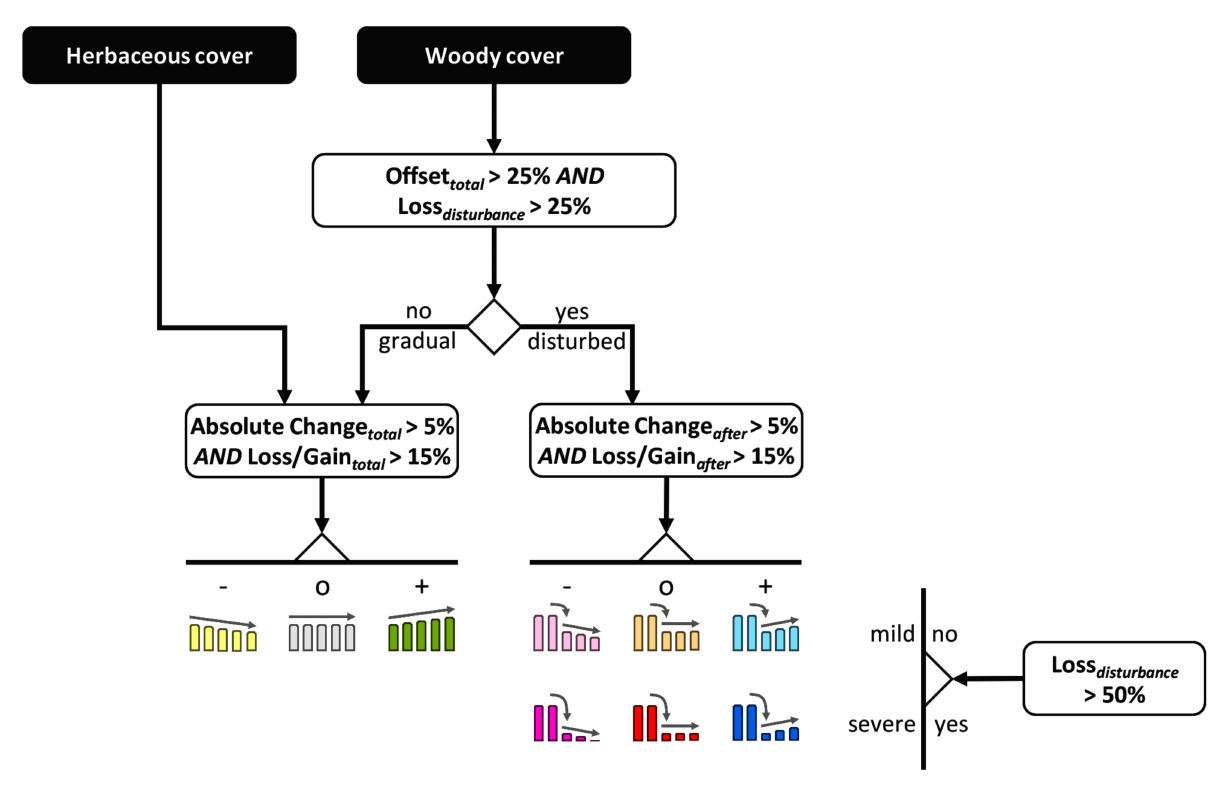
Figure 4. Expert-driven decision tree for classifying change and trend parameters for an information- enriched long-term vegetation change